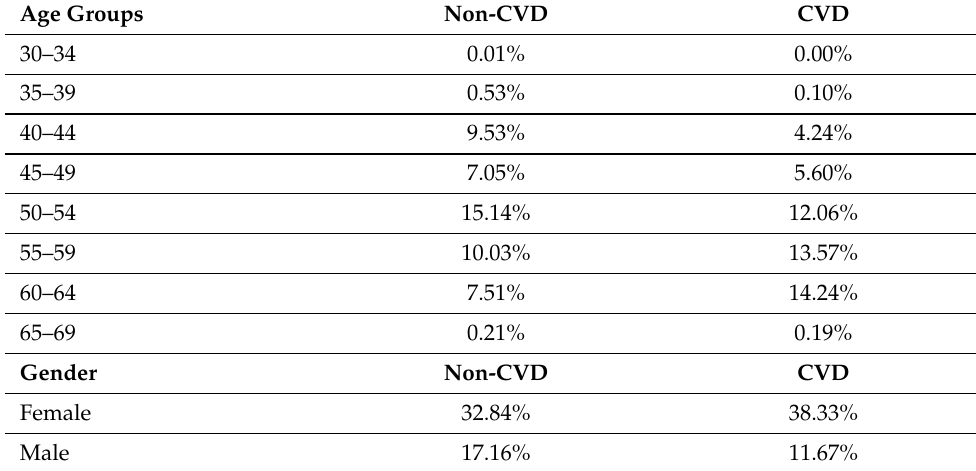
Table 4. Participants’ distribution per age group and gender type in the balanced